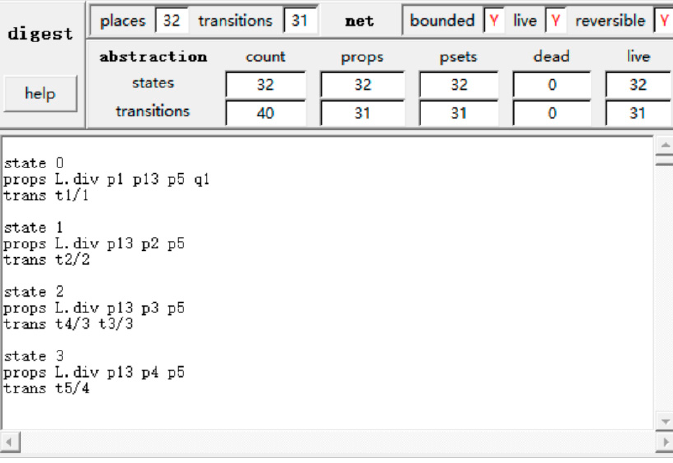
Figure 9. Veri fi cation result of the boundedness and liveness of Σ = {𝑁, 𝐹, 𝐺, 𝑀} . Figure 9. Verification result of the boundedness and liveness of Σ = { N , F , G , M }